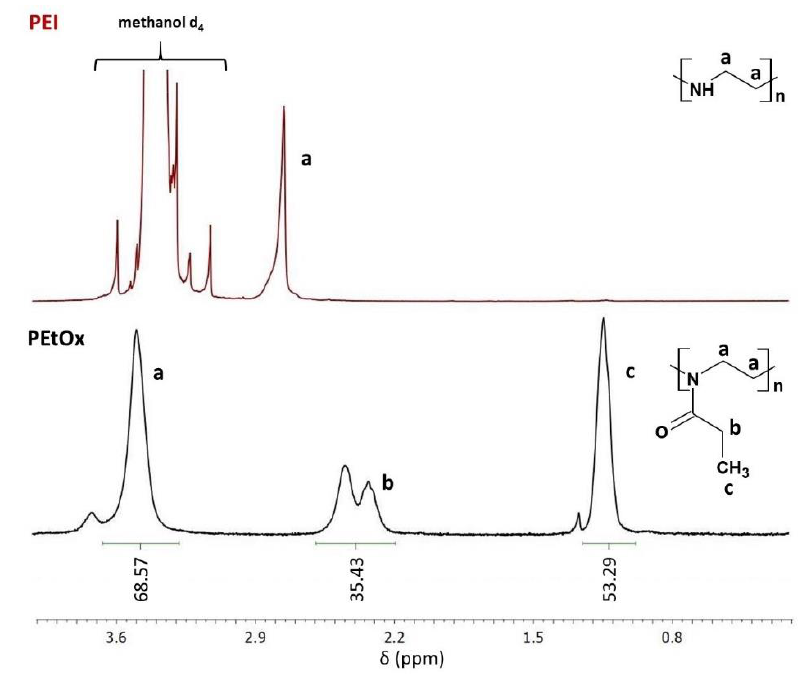
Figure 2. The 1 H NMR spectra of PEtOx and PEI.